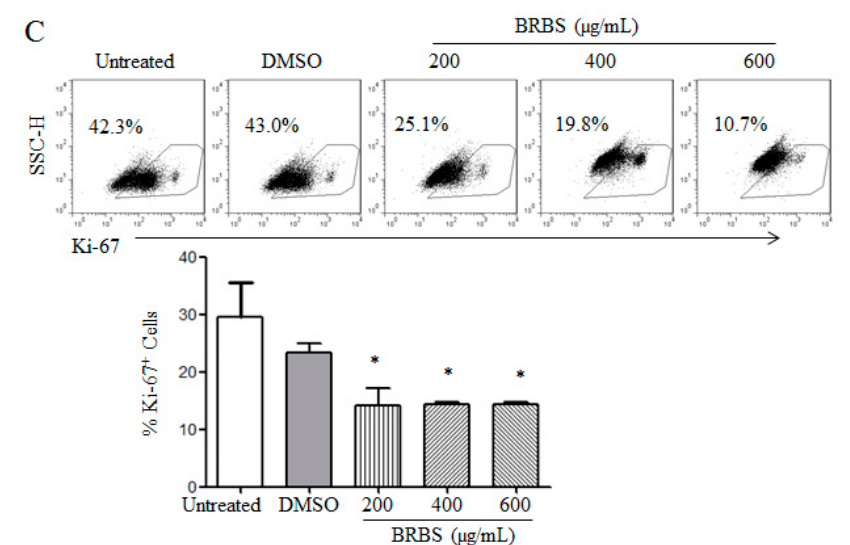
Figure 1. Effect of the n -butanol subfraction of B. rapa L. (BRBS) on morphology and proliferation of A549 cells ( A ) A549 cells were treated with BRBS for 24 h and observed under an inverted microscope. Scale bar = 50 µm; ( B ) Cells were treated with BRBS for 24, 48 and 72 h and cell viability was measured using an MTT assay. Data are expressed as Mean ± SEM (n = 6); ( C ) The expression of Ki-67 in A549 cells treated with BRBS for 24 h measured by flow cytometry. * p < 0.05; ** p < 0.01; *** p < 0.001 compared to